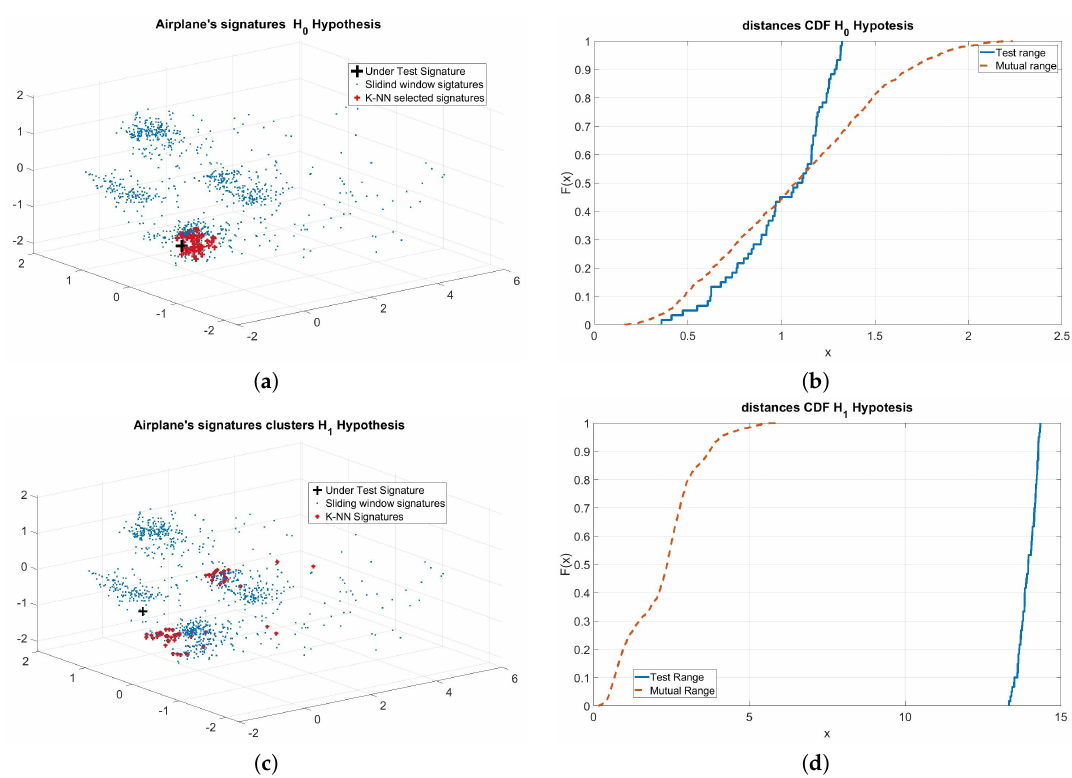
Figure 5. Example of application of the proposed method. ( a ) H 0 hypothesis, intruder not present: clusters of signatures representing the aircraft, + is the incoming signature, bold points represent the K-NN signatures; ( b ) d 1 and d 2 Cumulative Distribution Function (CDF); ( c ) H 1 hypothesis, intruder present: clusters of signatures representing the aircraft, + is the incoming signature from intruder, bold points represent the K-NN signatures; ( d ) d 1 and d 2